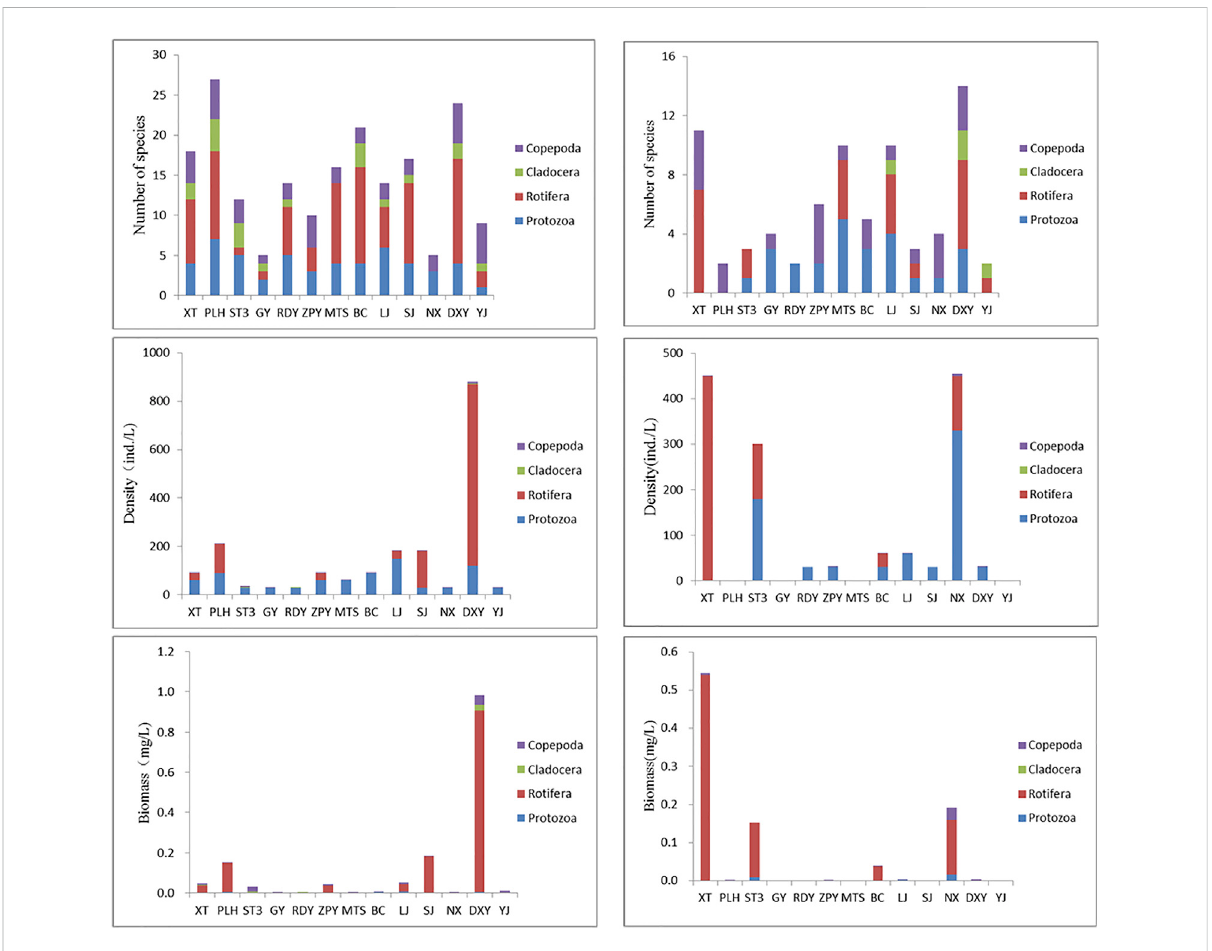
FIGURE 5 Zooplankton community composition of each sampling sites. The left column was the results in May and the right column was results in November.